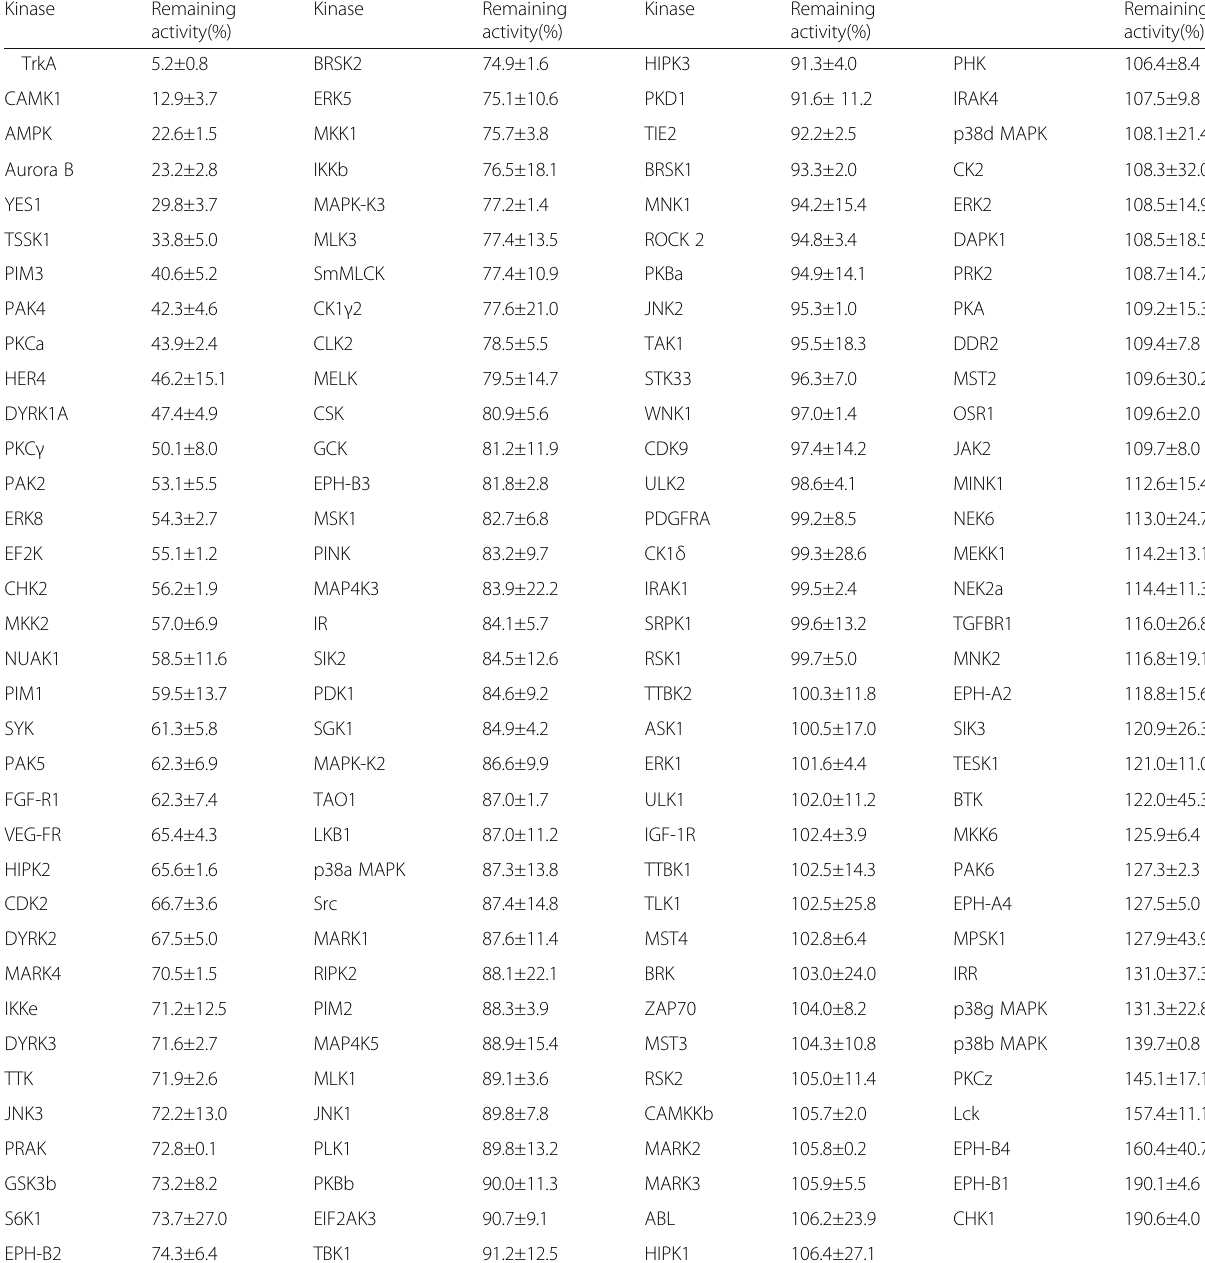
Table 1 Effect of cucurbitacin B (CuB) on protein kinase activities in a high-throughput screening Kinase Remaining Kinase Remaining activity(%) activity(%)